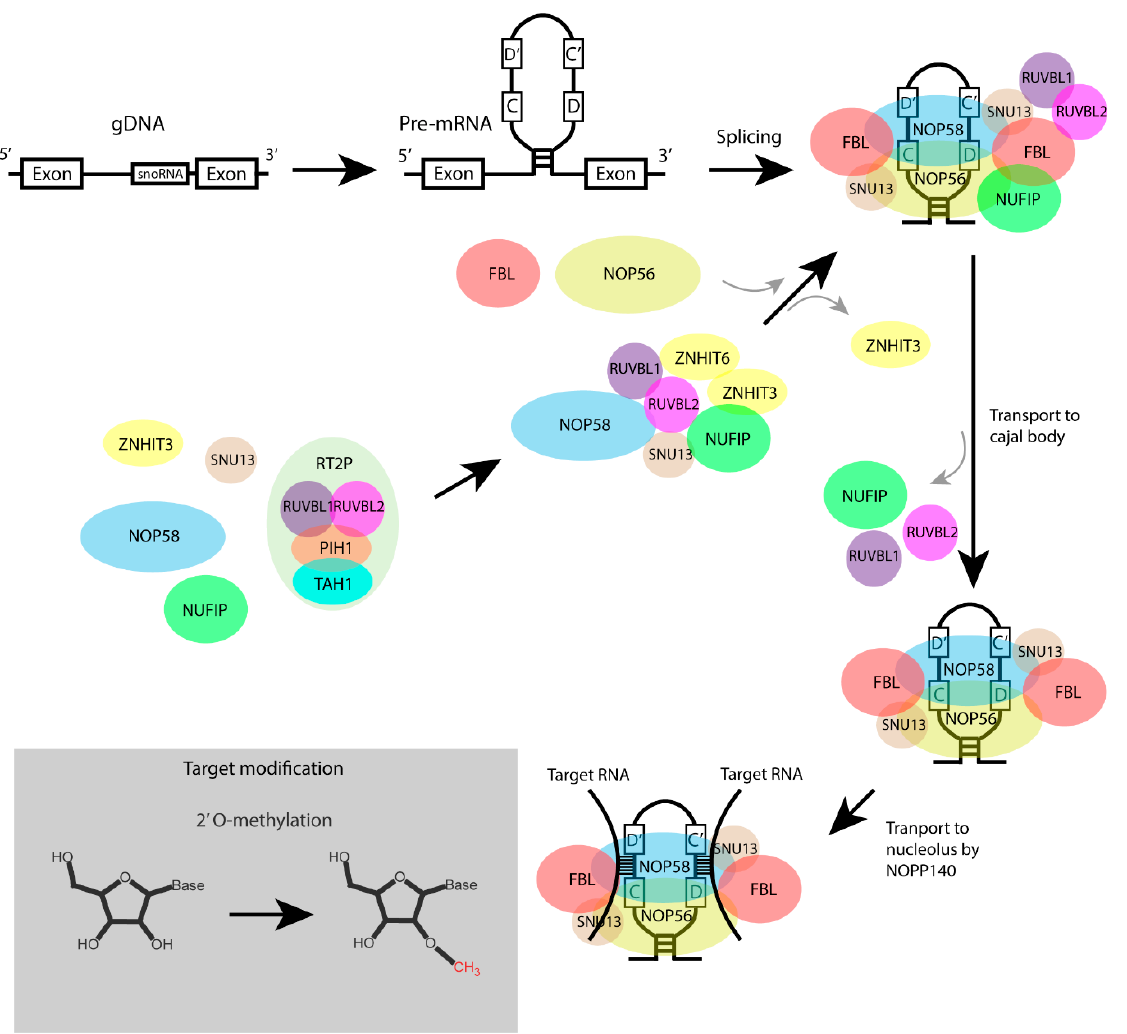
Figure 1 . Biogenesis of C/D box snoRNAs. C/D box snoRNAs are located near the 3 ′ splice site of the intron. During transcription, C/D box snoRNAs form their characteristic secondary RNA structure. The formation of C/D box snoRNPs requires different assembly factors, including the RUVBL1-RUVBL2-TAH1-PIH1 (R2TP) complex [31,40]. The RUVBL1 and RUVBL2 subunits of the R2TP complex bind, together with nuclear fragile X mental-retardation-interacting protein 1 (NUFIP), zinc finger HIT domain-containing protein 3 (ZNHIT3), and ZNHIT6, the core protein nucleolar protein 58 (NOP58) and small nuclear ribonucleoprotein 13 (SNU13) to form a new protein ZNHIT3 in the complex. The complex binds the C/D box snoRNA sequence during the splicing of the pre-mRNA. RUVBL1, RUVBL2, NUFIP, and ZNHIT6 are released from the complex and the